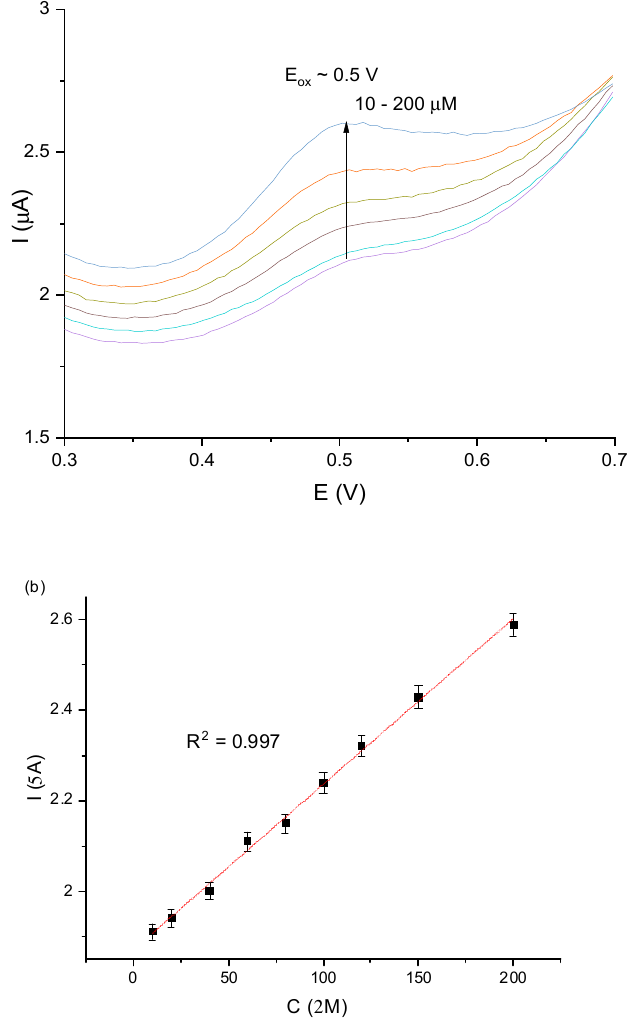
Figure 6. ( a ) Representative DPV scans for different concentrations of fT3 in the range of 10–200 µ M vs. Ag/AgCl; ( b ) linear relationship between current and fT3 concentration (10–200 µ